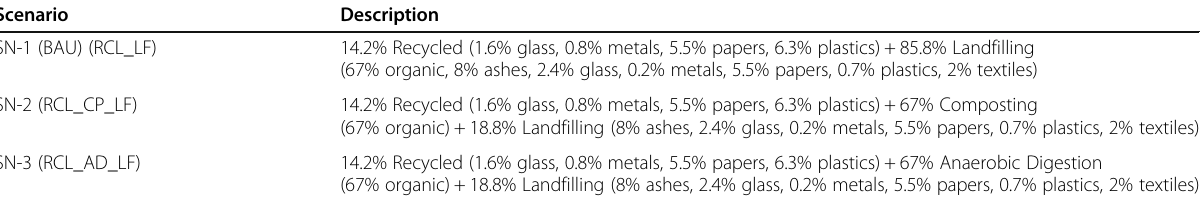
Table 1 Description of the considered scenarios for the life cycle assessment Scenario Description